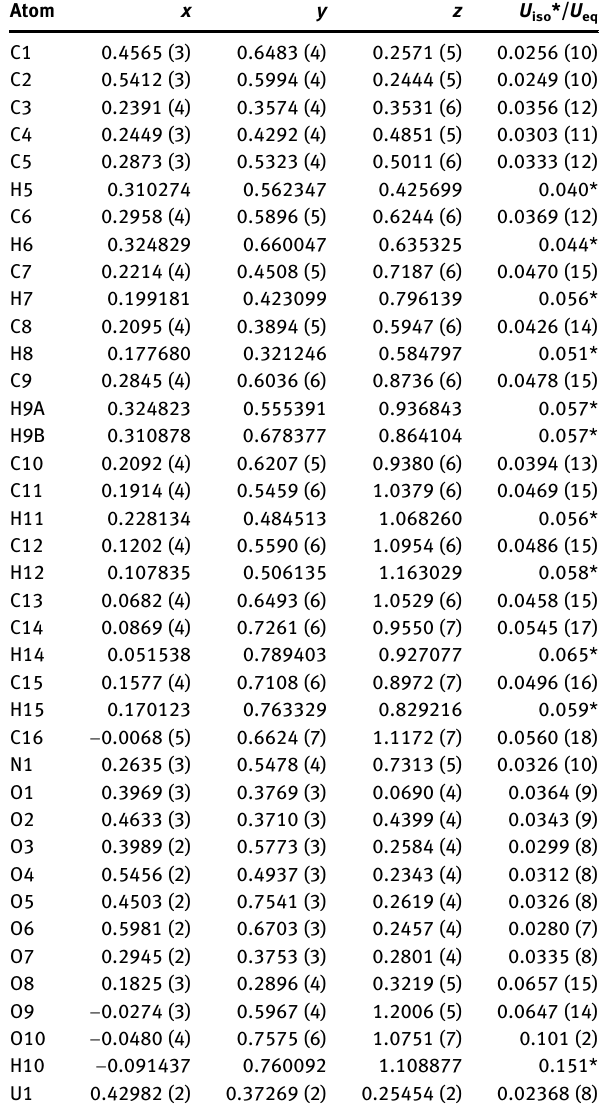
Table  : Fractional atomic coordinates and isotropic or equivalent isotropic displacement parameters (Å 